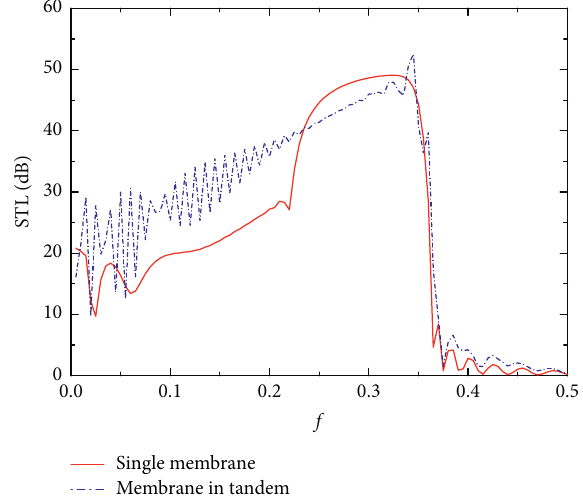
Figure 7: Comparison of STL between the single membrane setup and the membrane in